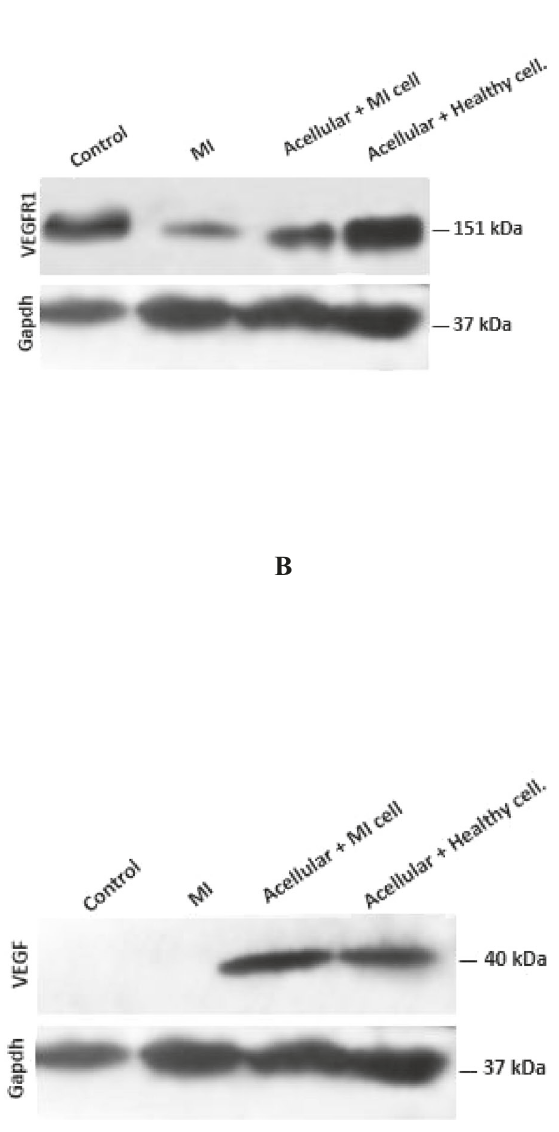
Fig. 4 The evaluation of VEGFR1 protein expression in healthy and MI Cell lysates from 2D and 3D cultures ( A ) and VEGF protein conditioned media from 2D and 3D cultures ( B ). The VEGFR1 protein expression from MI and healthy cell lysates cultured in the 3D system was signi fi cantly higher than VEGF protein expression in MI and healthy cell lysates cultured in the 2D system. The expression levels of VEGF protein were severely elevated in conditioned media from the